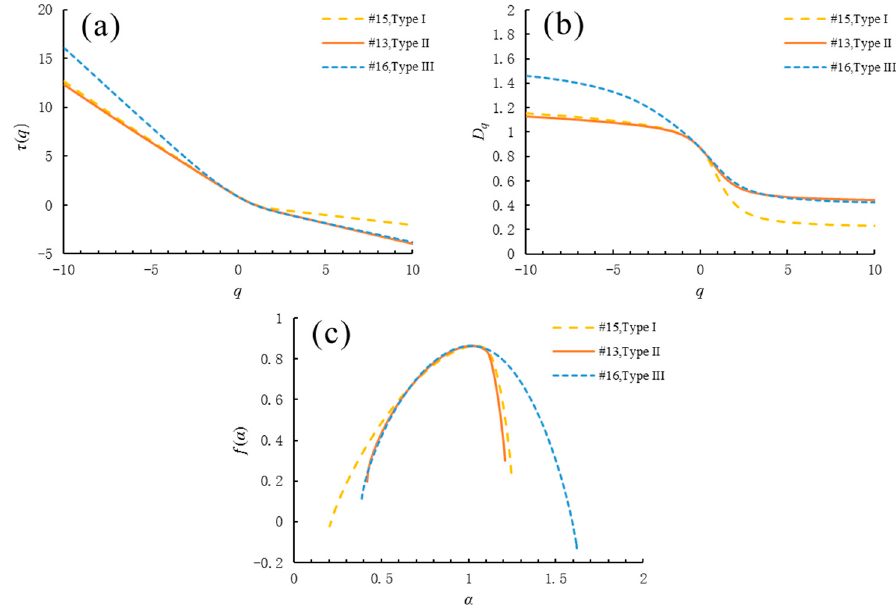
Figure 8. Multifractal spectrum of MICP data in tight sandstone samples with different types of reservoirs. ( a ) the mass exponent (cid:2028)((cid:1869)) of different types; ( b ) the generalized dimension spectrum